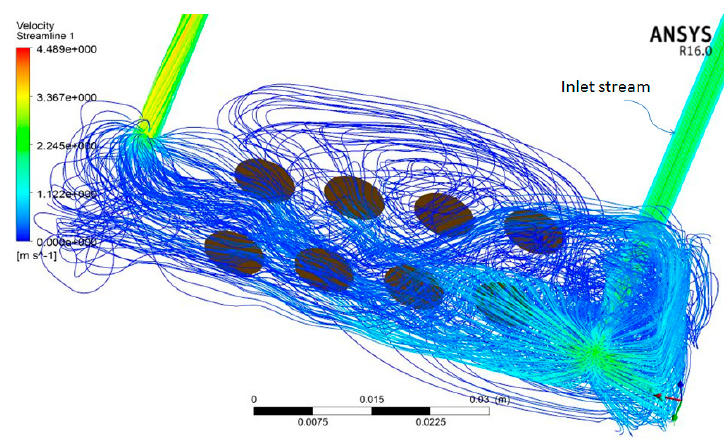
Figure 12. Velocity streamlines distribution of the gas flow relative to the sensors at 1 s .